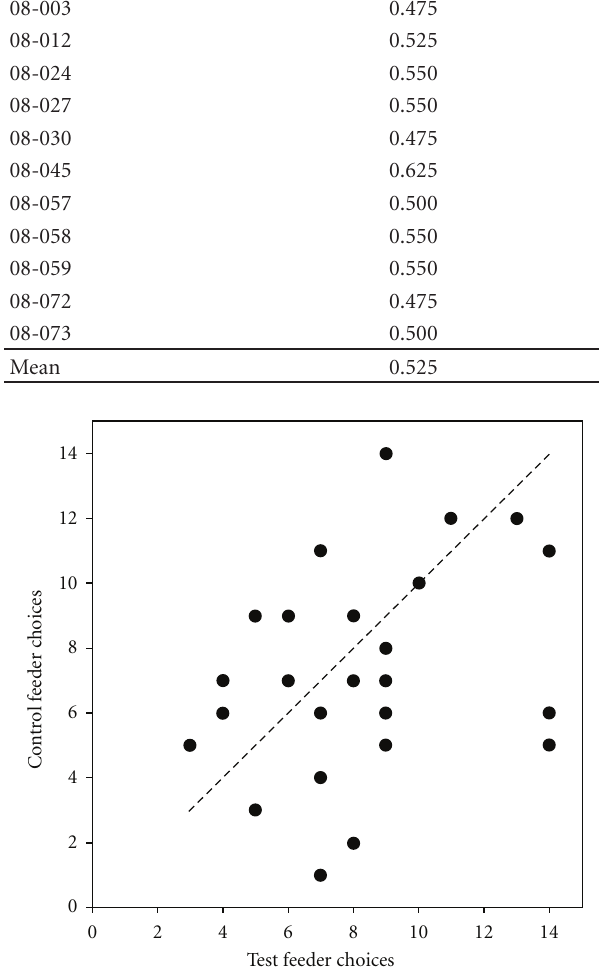
Figure 1: The number of choices for the test feeder and control feeder made by individuals that made at least eight choices during a trial. Each symbol represents an individual. The dotted line represents choices of 1